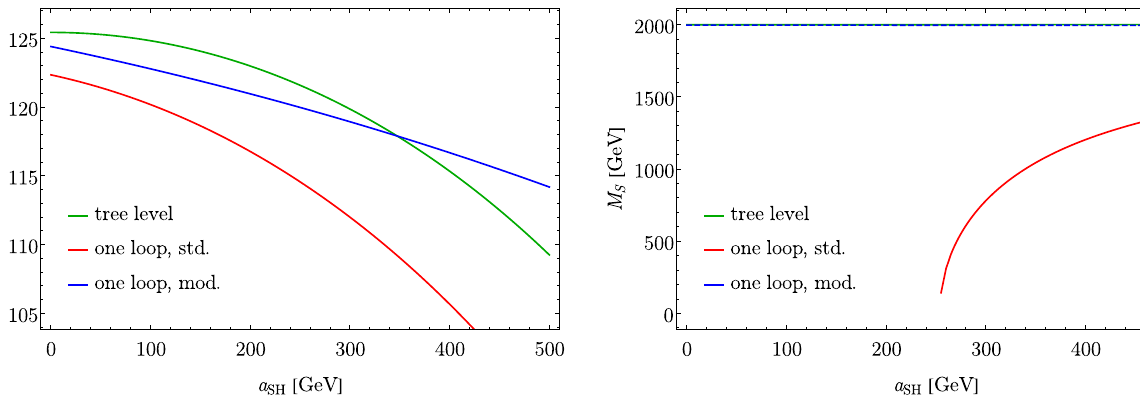
= Q = blue curves correspond to the one-loop results using respectively the S standard (Eq. (2.2)) and modified (Eq. (2.4)) treatments of tadpoles